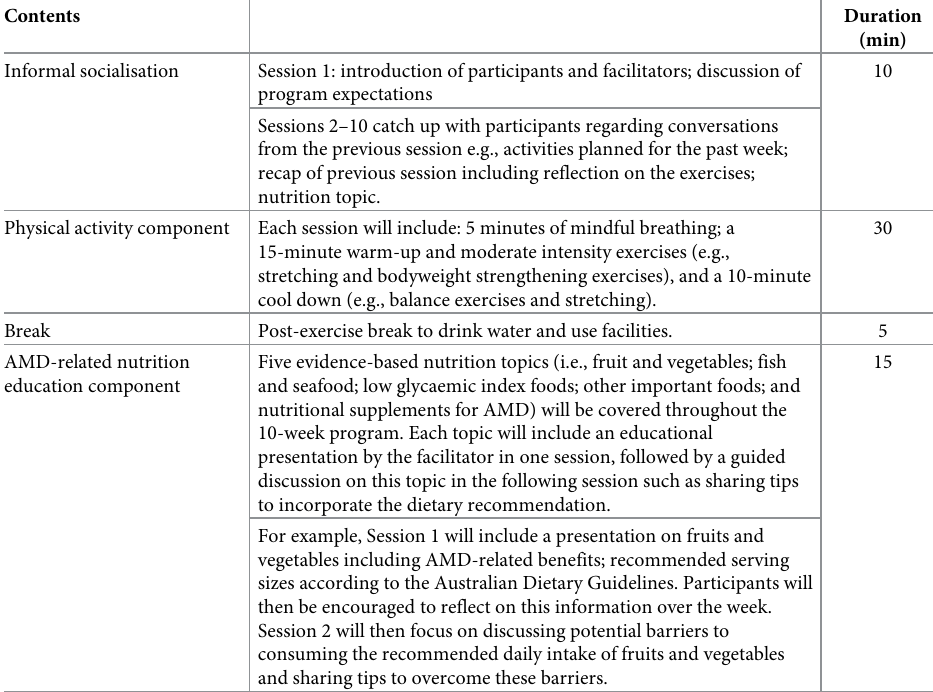
Table 2. Overview of the proposed MINGLE